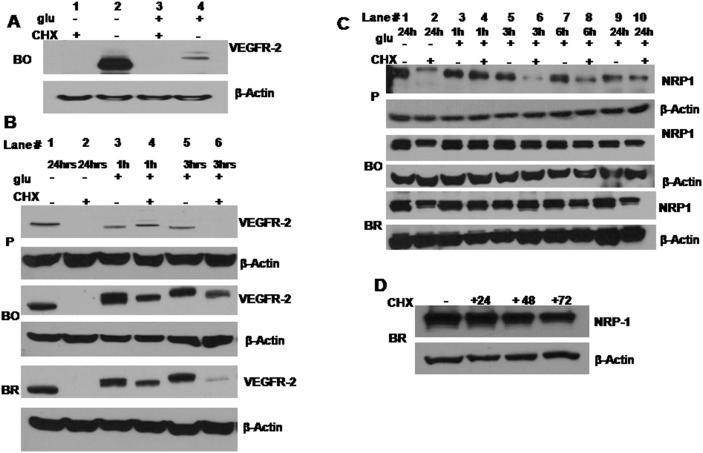
The glycosylated VEGFR2 found upon glucose re-exposure was not a product of a de-novo protein synthesis.(A) Cyclohexamide treatment for a period of 24 hrs depleted VEGFR2 protein from all three cell lines. The blot in this panel demonstrates that cyclohexamide depleted VEGFR2 from the MDA-MB-231BO cells (regularly expressing the highest level of VEGFR2 among the three cell lines) whether they were hypoglycemic or hyperglycemic (lane 1 and 3). The control cyclohexamide negative samples –glu −CHX and +glu -CHX showed detectable VEGFR2 expression (lane 2 and 4). (B) VEGFR2 was completely depleted from the three cell lines when grown in hypoglycemia in the presence of CHX (lane 2). The samples in lanes 3 and 5 are cells exposed to hypoglycemia for 24 hrs without CHX and glucose was restored for 1 hr (lane 3) or 3h (lane 5), respectively. Comparing the former two lanes (3 and 5) shows clearly that the VEGFR2 band was increasing in molecular weight as the time of glucose exposure increased; this is very prominent in the middle (MDA-MB-231BO) and bottom blots (MDA-MB-231BR). The samples in lane 4 and 6 were glucose restored for 1 hr and 3 hrs respectively with CHX added at the time of glucose restoration. After 3 hr of CHX and glucose restoration of MDA-MB-231P cells, the VEGFR2 band was not detectable (lane 6- P), however the MDA-MB-231BO and MDA-MB-231BR cells (lane 6 BO, lane 6 BR) expressed a detectable VEGFR2 band. Note: β-Actin was used in all the blots as a protein loading control. (C) Stability of NRP-1 expression under low glucose and CHX treatment. NRP-1 was detected in the same samples as in the previous panel (B) and it did not show a profound decrease in its expression in both MDA-MB-231BO and MDA-MB-231BR. However in MDA-MB-231P samples the NRP-1 band pattern was changed after 24 hrs of hypoglycemia in the presence of CHX (lane 2). The NRP-1 band was also decreased in the glucose-restored samples with CHX (added at the time of restoration) (lanes 6, 8, and 10). (D) The blot shows that in MDA-MB-231BR cells the NRP-1 protein was resistant to CHX treatment for up to 72 hrs of exposure. Note: β-Actin was used in all the blots as a protein loading control.